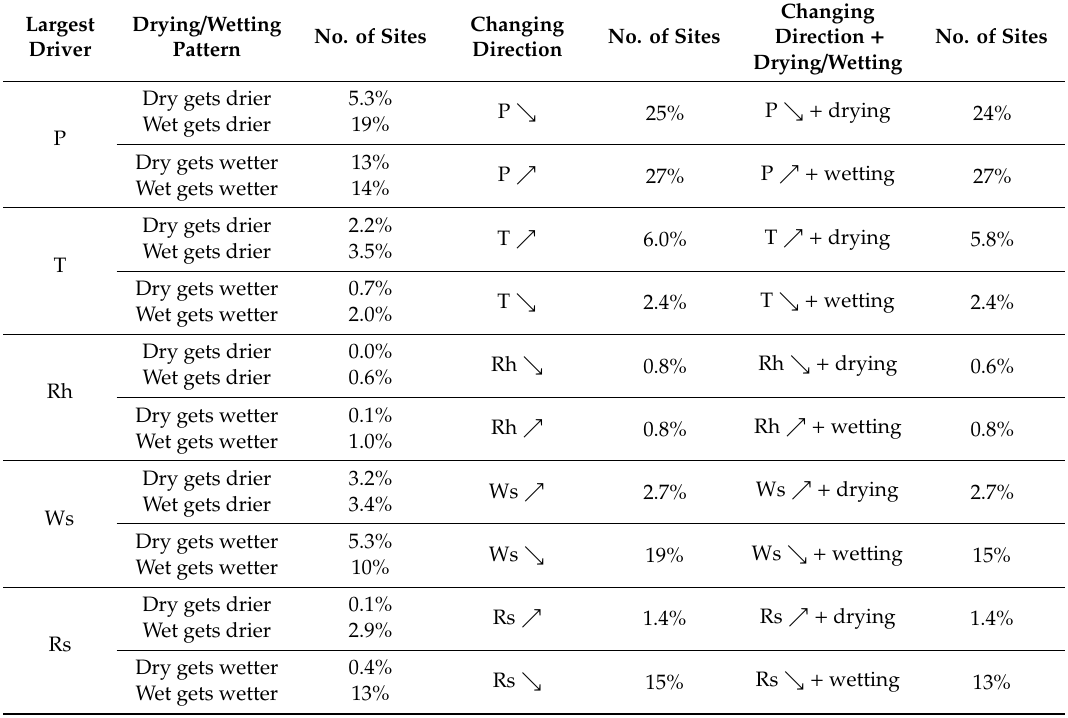
Table 3. Cross-comparison of the drying / wetting patterns and the changing directions of the largest climatic drivers from 1961–1988 to 1989–2016. The 713 climate stations are categorized into five groups according to the largest climatic driver of drying or wetting, including precipitation (P), temperature (T), relative humidity (Rh), wind speed (Ws), and radiation (Rs). Increase and decrease in the climatic drivers are denoted by “ (cid:37) ” and “ (cid:38) ”,